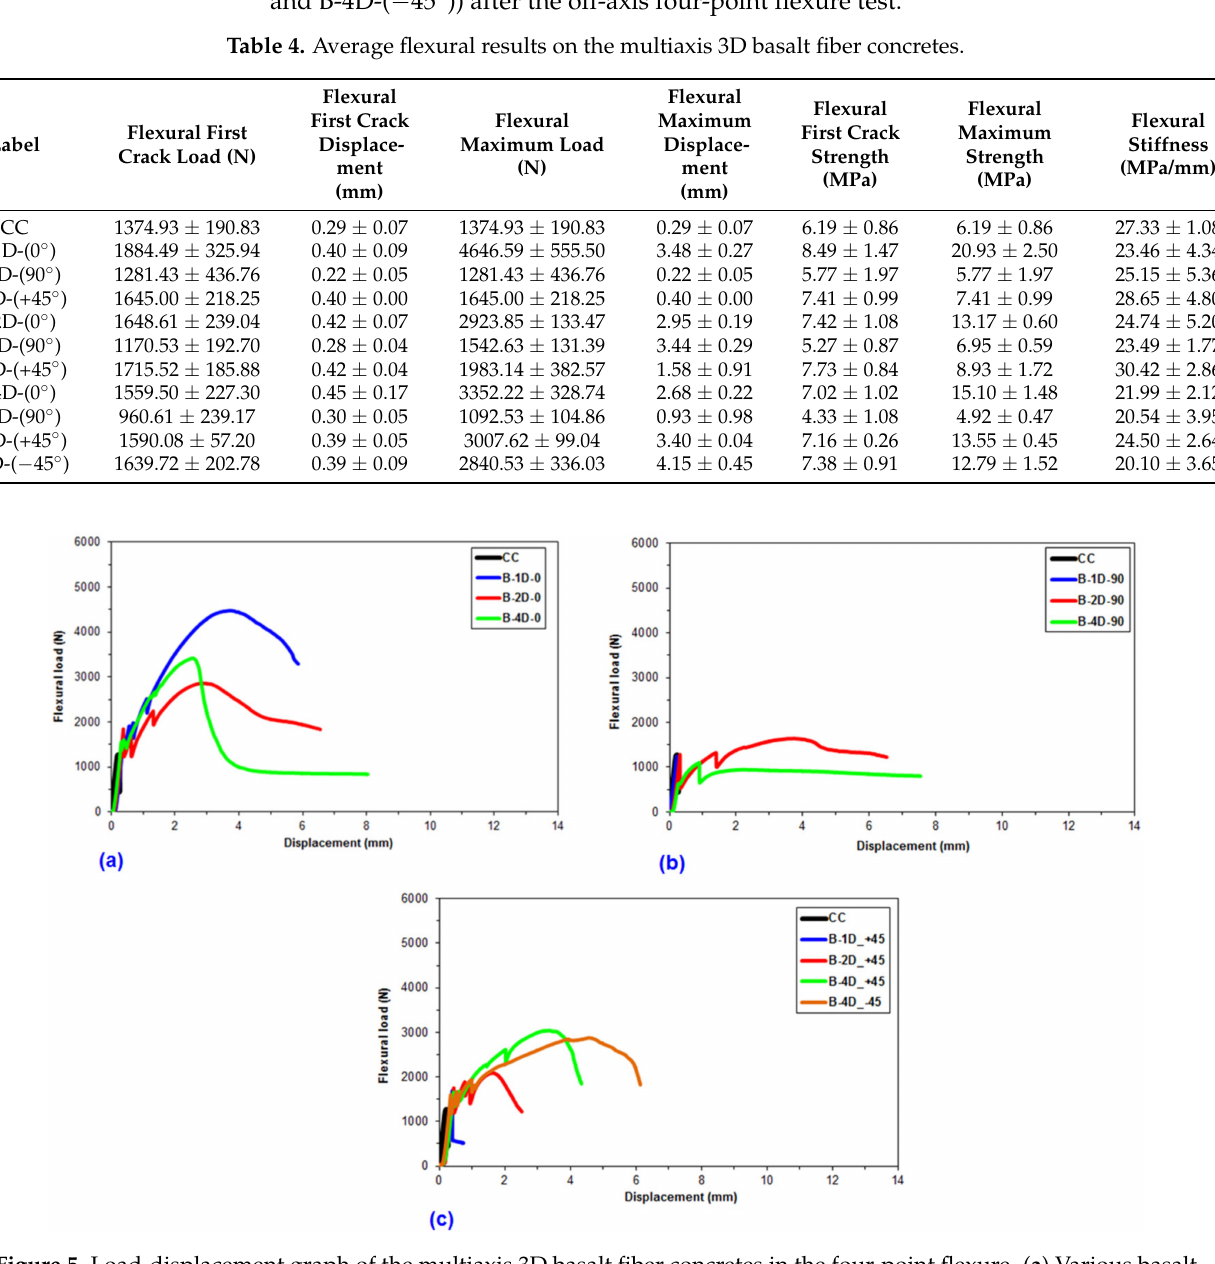
Figure 5. Load-displacement graph of the multiaxis 3D basalt fiber concretes in the four-point flexure. ( a ) Various basalt fiber TOWs concrete structures at 0 ◦ flexure; ( b ) various basalt fiber concrete structures at 90 ◦ flexure test and ( c ) various basalt fiber concrete structures at bias directions